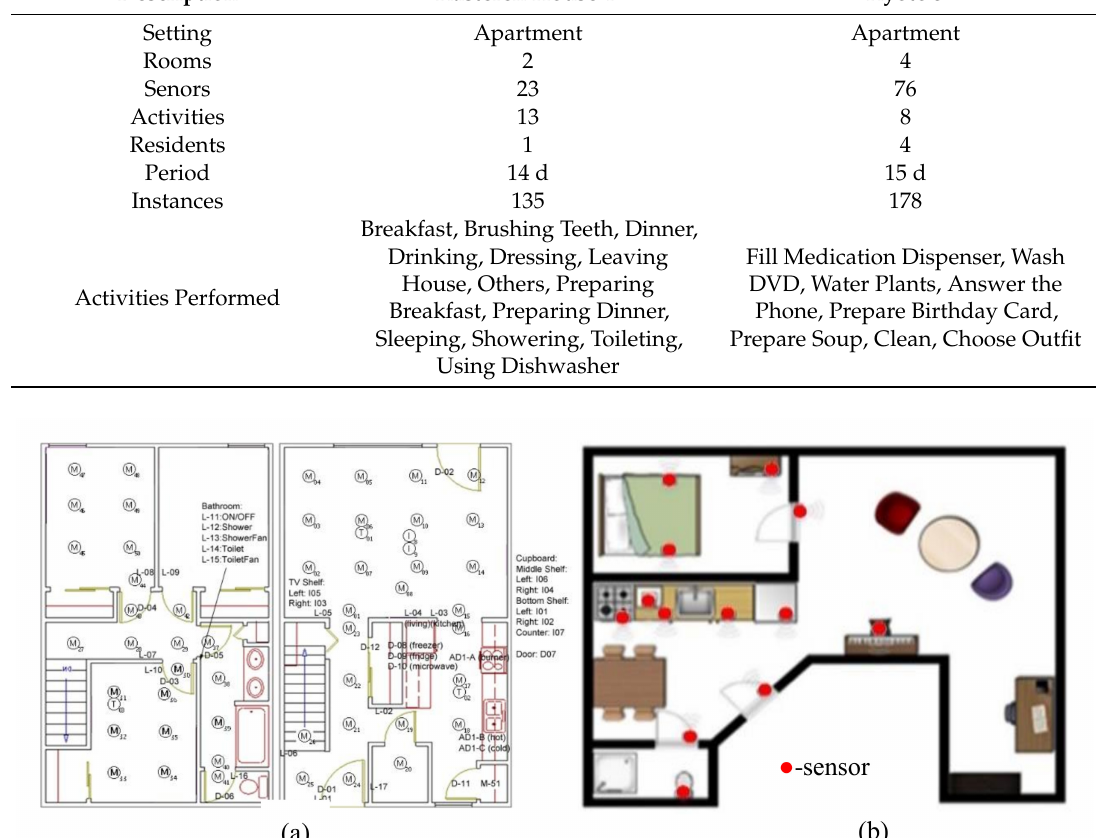
Figure 8. Sensor layout for ( a ) Kyoto 3 Dataset ( b ) Kasteren House B